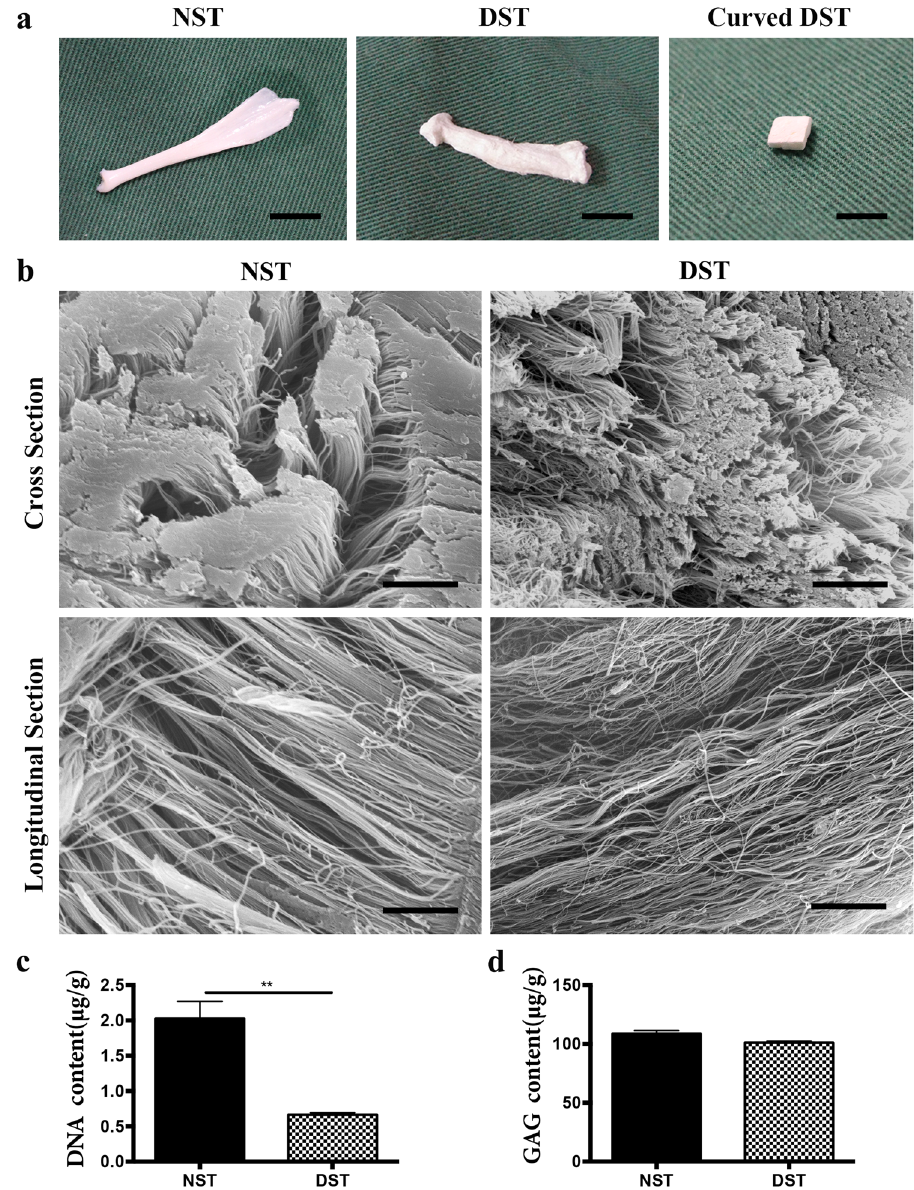
Figure 1. Characterization of the DST. ( a ) Gross appearance of tendon scaffolds. Scale bar = 5 mm. ( b ) SEM characterization for the surface topography of NST and DST. Scale bar = 10 μ m. ( c ) DNA content of NST and DST. ( d ) GAG content of NST and